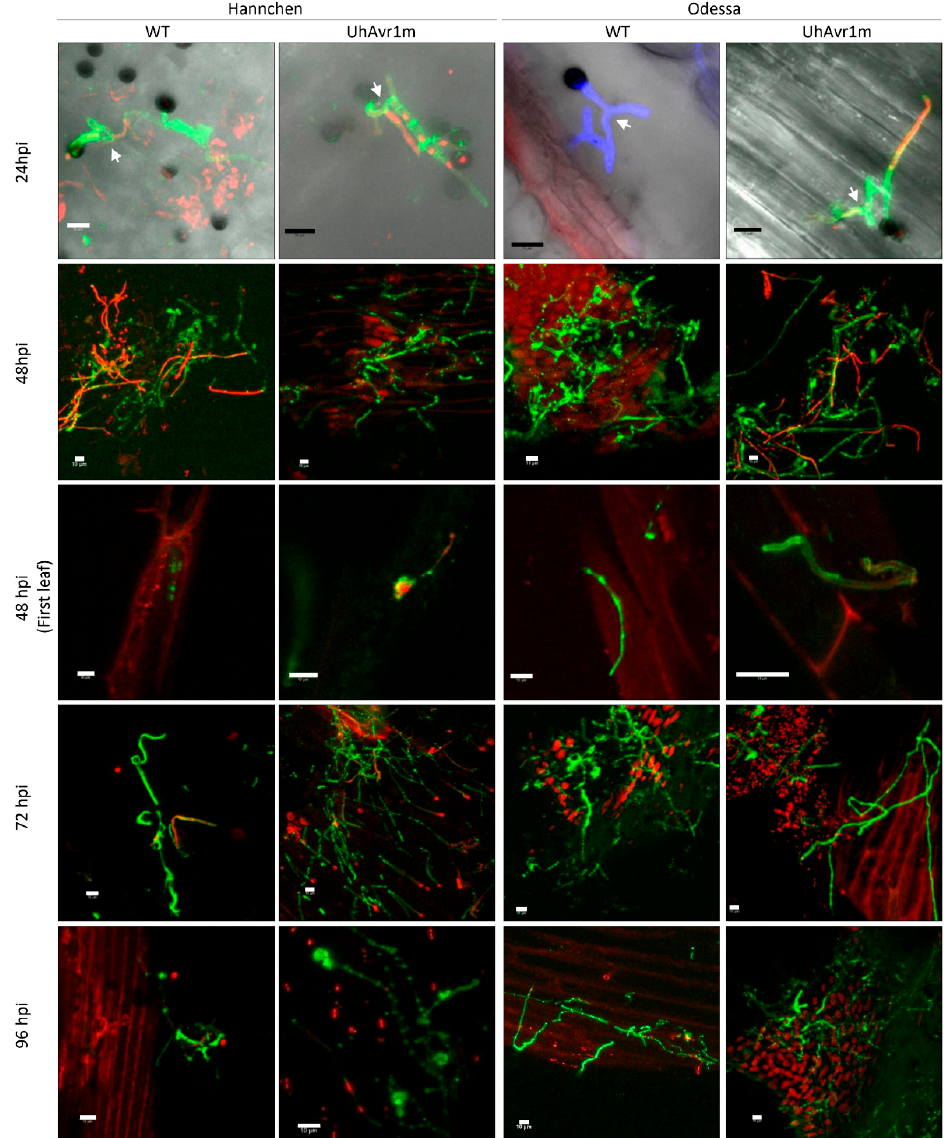
Figure 1. Progression of infection by U. hordei during early stages. Confocal microscopy of barley cv. Odessa ( ruh1 ) and Hannchen ( Ruh1 ) shows di ff erential fungal growth and infection by wild type (WT) or UhAvr1m teliospores at early stages of infection. Tissues were stained with WGA-AF488 (green) or Uvitex2B (blue) together with propidium iodide (PI) (red). Teliospore germination, sporidia formation and mating via conjugation hyphae (arrow) were seen on the coleoptile surfaces of both cultivars at 24 hpi. At 48 hpi, dead hyphae (red) were observed which were prominent for WT teliospores on cv. Hannchen and for UhAvr1m teliospores on cv. Odessa. Lower fungal growth from UhAvr1m teliospores at 72 hpi on the cv. Odessa recovered by 96 hpi. Similarly, reduced fungal growth from WT teliospores was seen in the cv. Hannchen starting from 48 hpi. Scale bar represents 10 µ m. All images are maximum intensity projections of confocal stacks except for 24 hpi Odessa WT which is a confocal snapshot of a single optical section. Confocal imaging was performed on a minimum of three infected seedlings. Experiments were repeated two times with similar results and representative images are displayed.